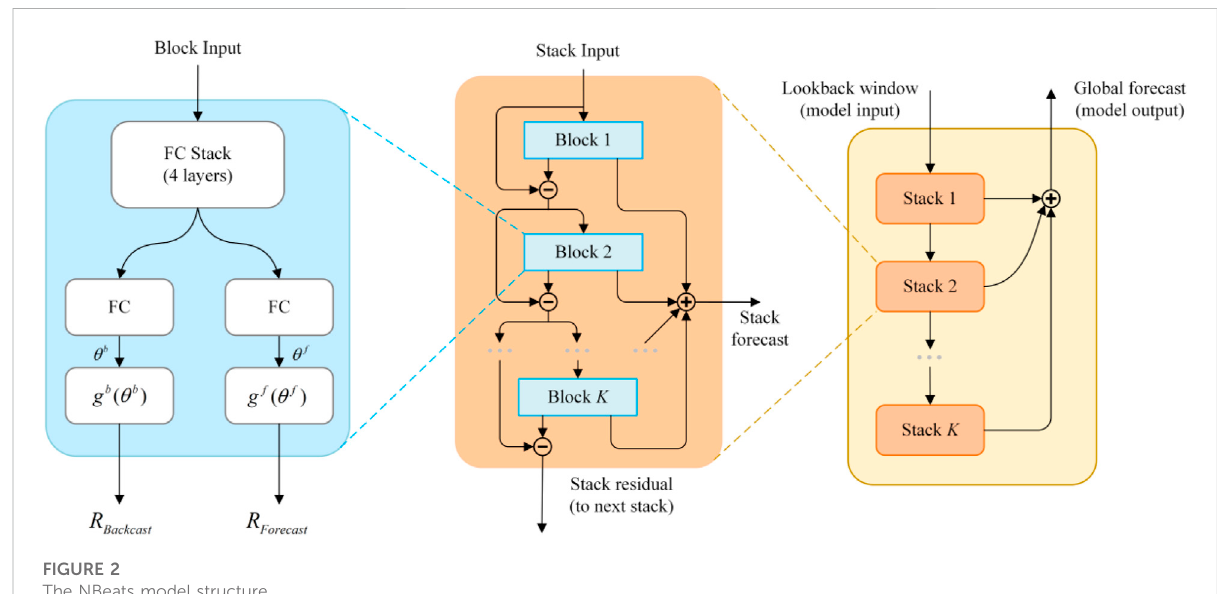
FIGURE 2 The NBeats model